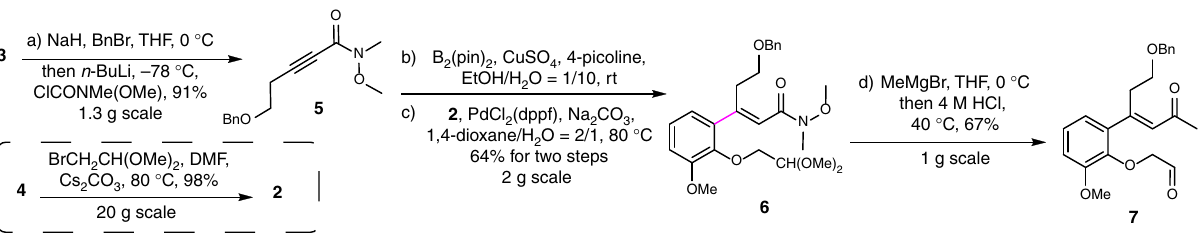
Fig. 3 The preparation of compound 7 on a gram scale. The enone precursor 7 was synthesized in four steps and the key transformation included a Suzuki coupling reaction